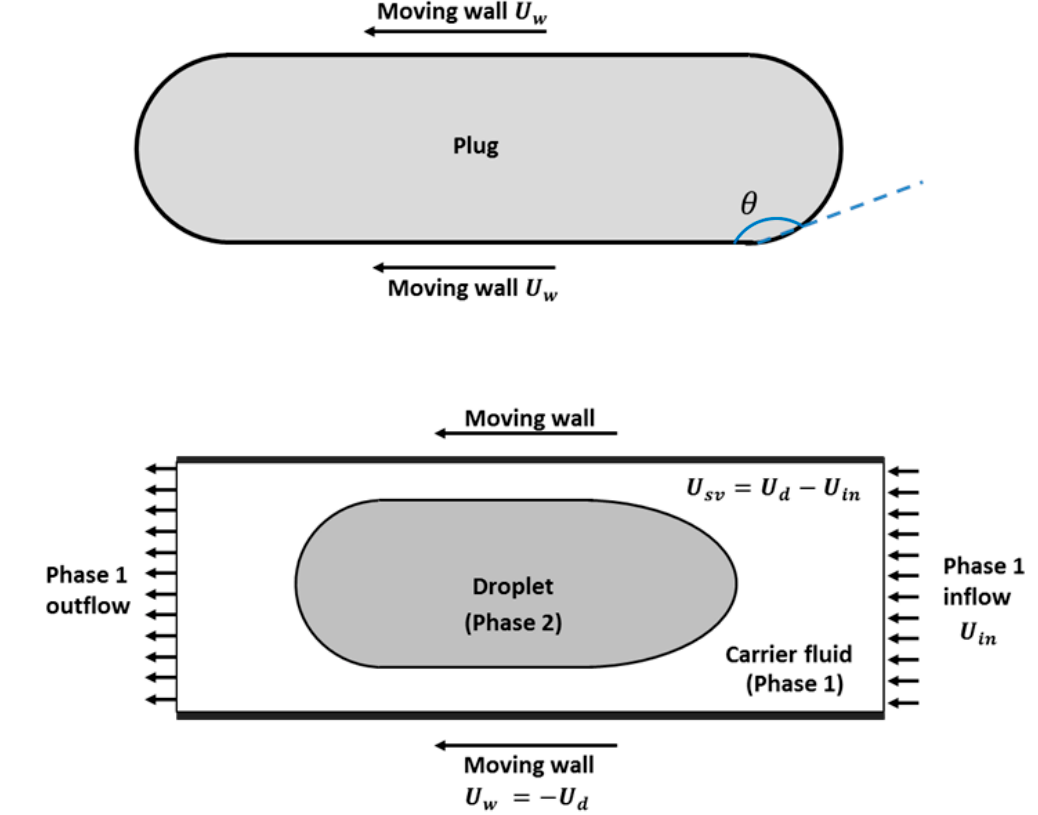
Figure 1. Computational domain for modelling droplet or plug transport in a two-phase fixed frame of reference. ( a ) Single-phase moving frame of reference and ( b ) two-phase moving frame of reference. The two-phase moving frame of reference (Figure 1b) is a compromise between the single-phase moving frame of reference and the fixed frame of reference. The two-phase moving frame of reference works on a computational domain smaller than the two-phase fixed frame of reference. It is also more versatile in application compared to the single-phase moving frame of reference, especially where capturing of interface, wall shear, and flow recirculation are important [40]. The considered domain captures the interfaces, a single plug or multiple plugs, and the surrounding flow fields, including the second